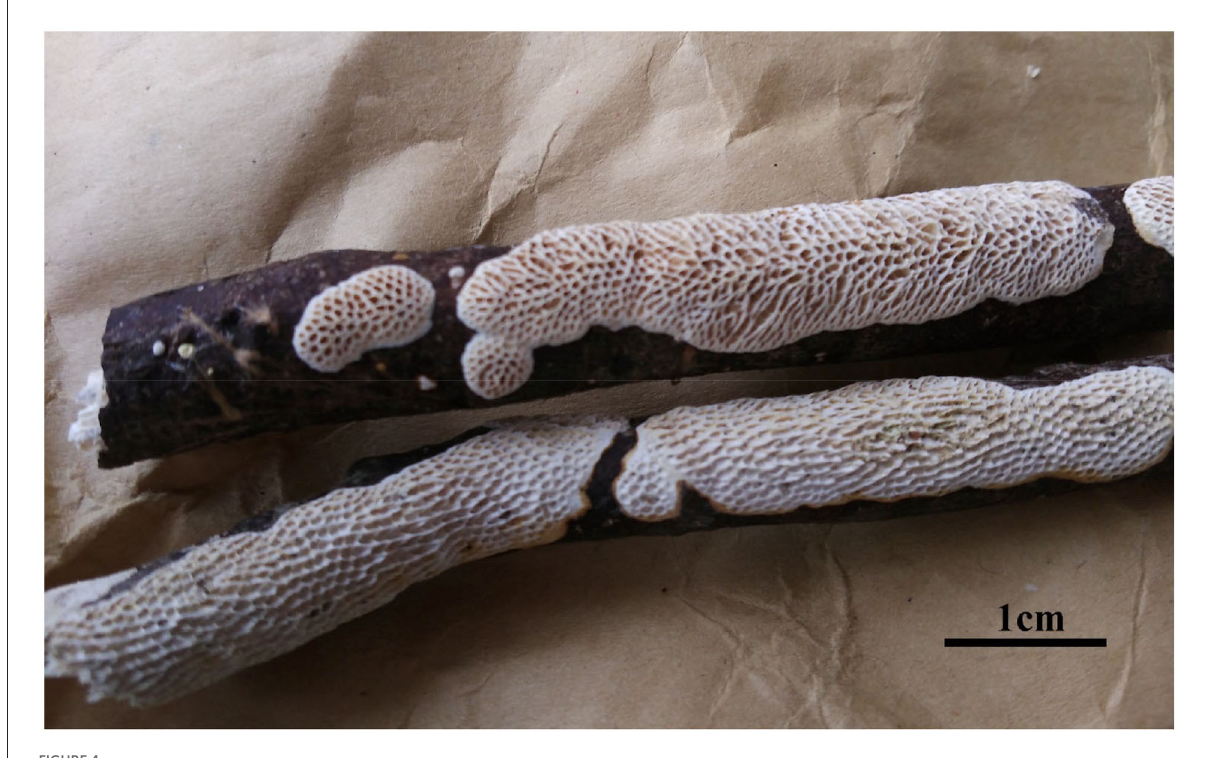
FIGURE4 Basidiocarps of Jorgewrightia irregularis (Dai